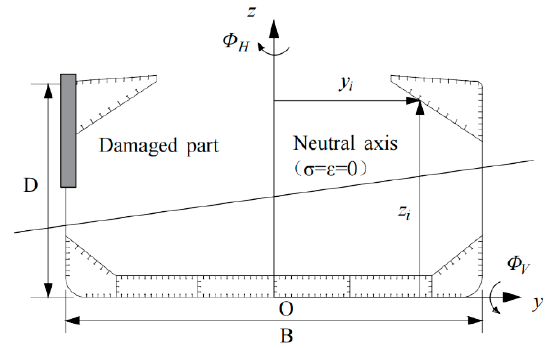
Figure 5. Cross section of a damaged ship.